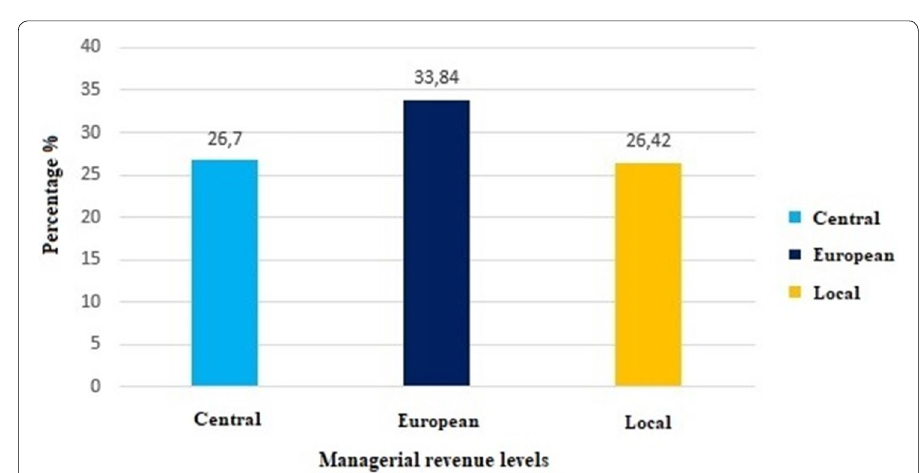
Fig. 8 Degree of confidence in the management of tax